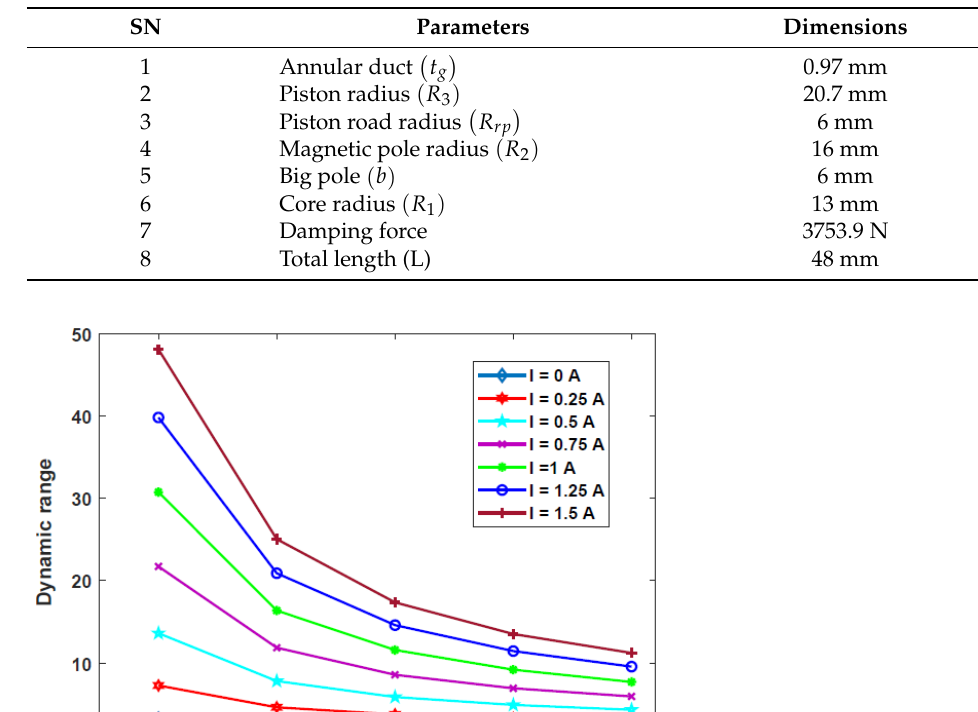
Figure 7. Pareto front between objective functions. Table 3. Optimal geometric parameters for the HARMRD.